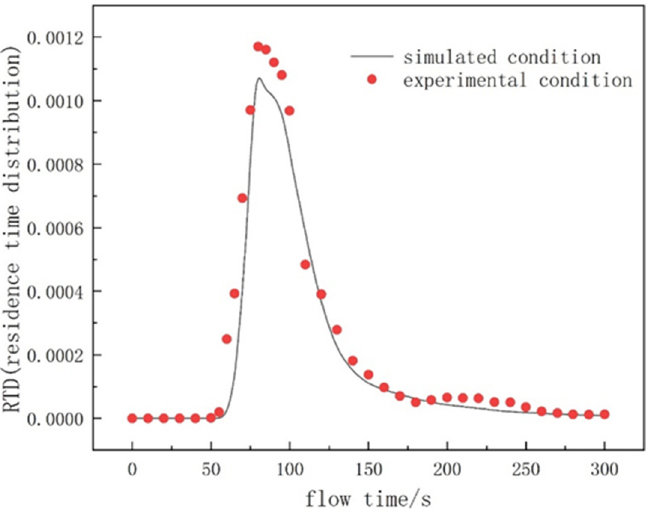
Figure 10. Comparison of residence time distribution